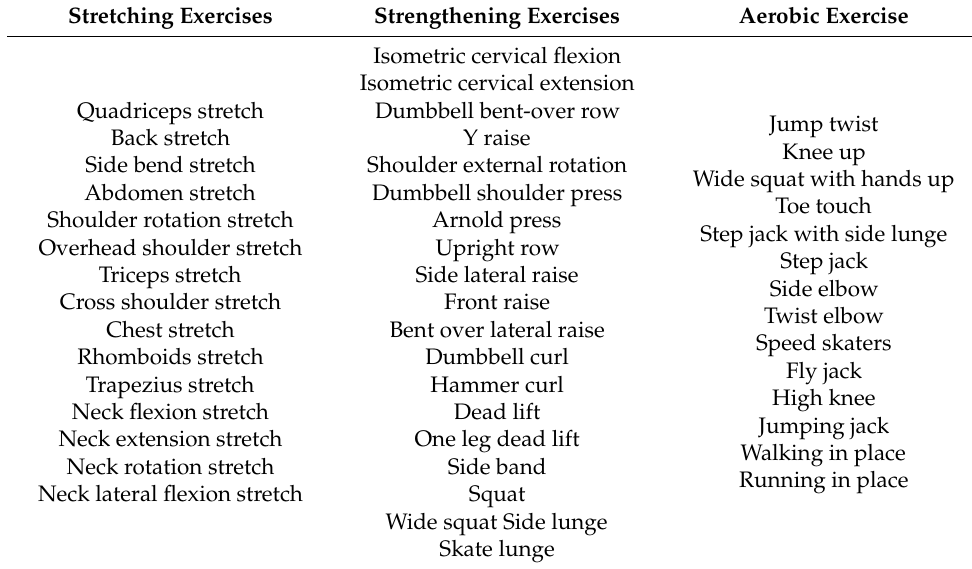
Table 1. List of Weelo